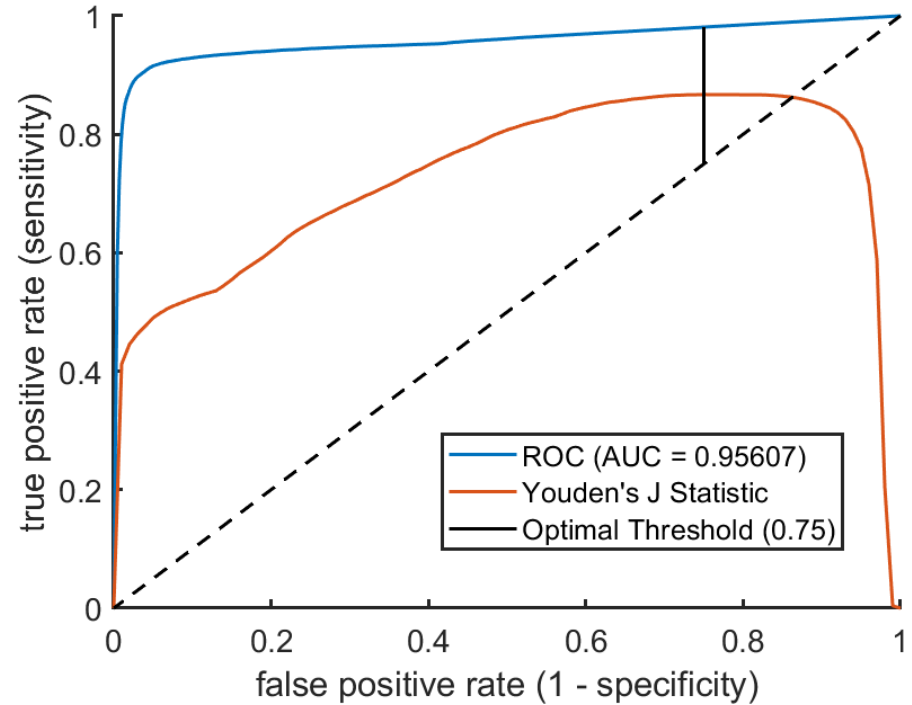
Figure 6. Sensitivity and specificity benchmarks: Receiver Operator Characteristics (ROC) and J- statistic curves for quasar prediction using the g and r filters from training data. The maximum of Youden’s J-statistic located at the vertical black line is taken as the optimal threshold for the density ratio. The black dashed line represents 50/50 chance of guessing